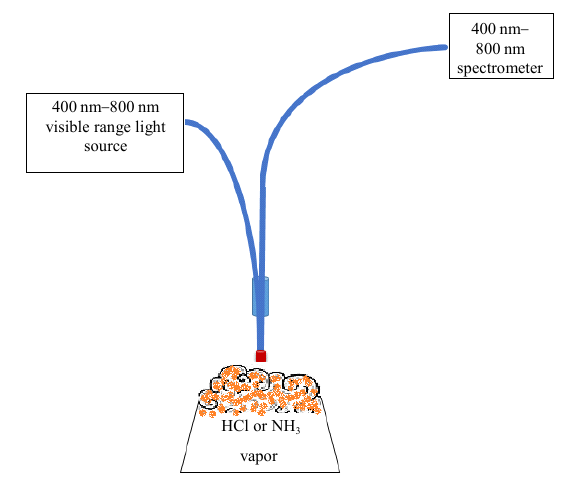
Fig. 2 Spectroscopy setup for reflectance analysis of acid and base exposure.